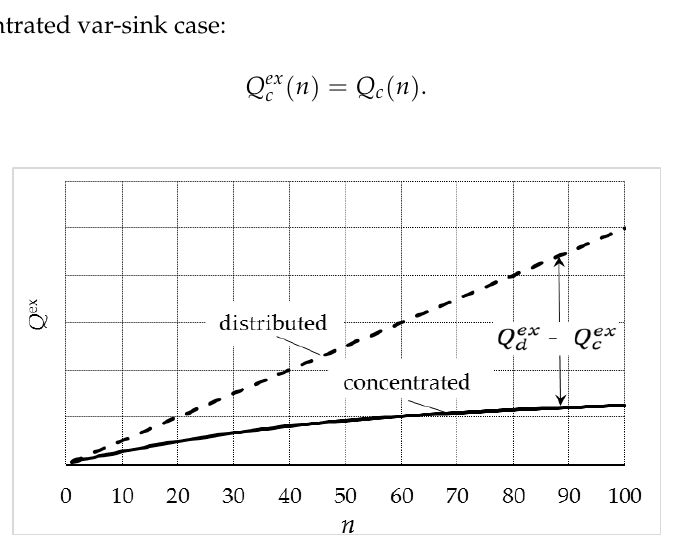
Figure 6. The theoretical exchanged reactive power as a function of the bus number for the distributed and concentrated var-sink cases.